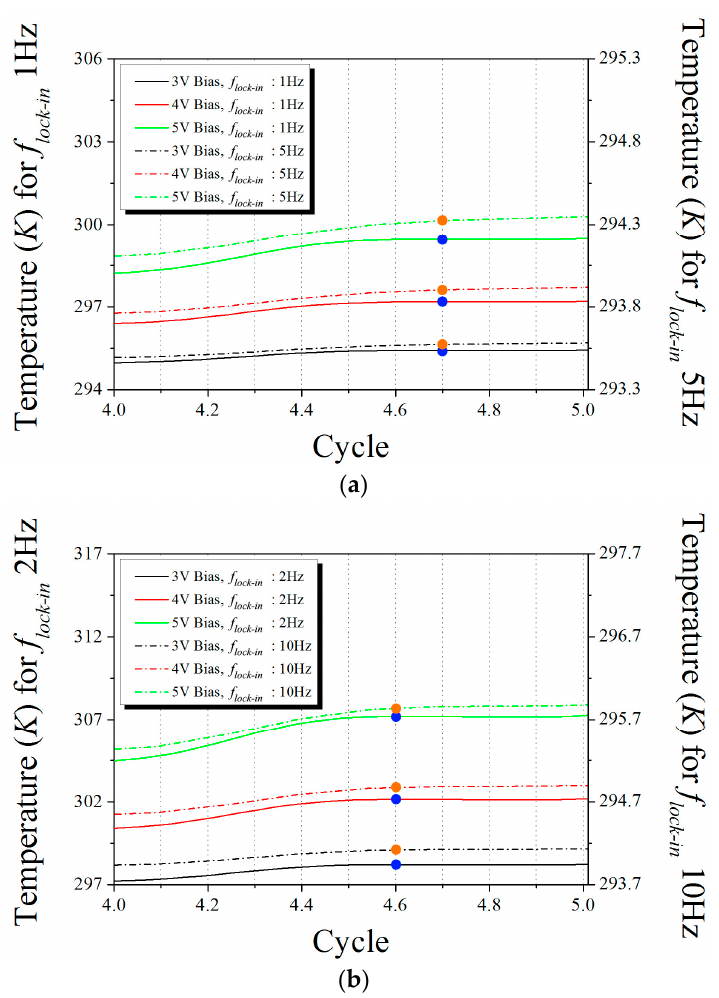
Figure 8. Enlarged view of the thermal response profiles for all bias voltages with two lock-in frequencies: ( a ) 1 Hz and 5 Hz for the two-layer SSHSC; ( b ) 2 Hz and 10 Hz for the three-layer SSHSC, at final cycle.